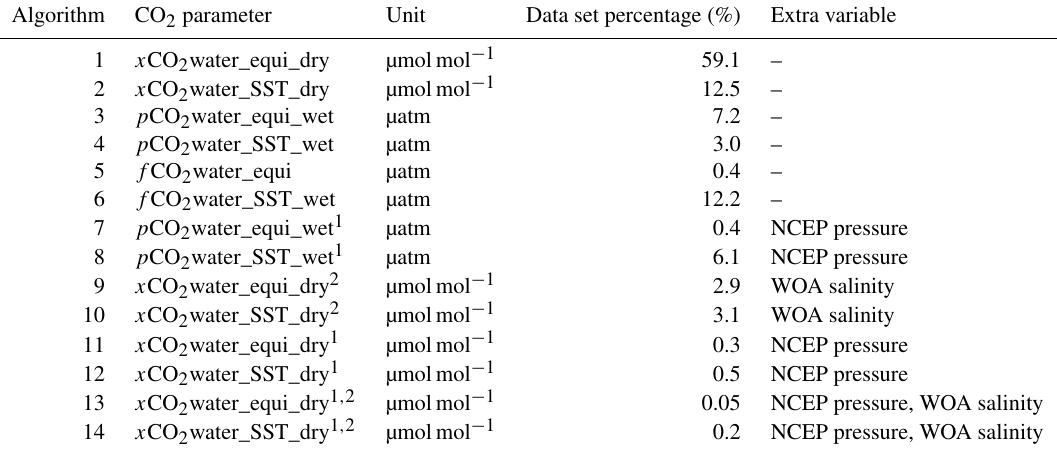
Table 6. Algorithms and surface water CO 2 parameters used in the calculation of recommended f CO 2 ( f CO 2 rec) at sea surface temperature in version 3 (after Pfeil et al., 2013). Algorithm 1 was the preferred method, followed by algorithm 2 and so forth. The algorithm used for each data set is stated in the output files (Table 9). In the case of incomplete reporting, NCEP (National Centers for Environmental Prediction) atmospheric pressure (Kalnay et al., 1996; NCEP, 2014) and WOA (World Ocean Atlas) 2005 salinity (Antonov et al., 2006) were